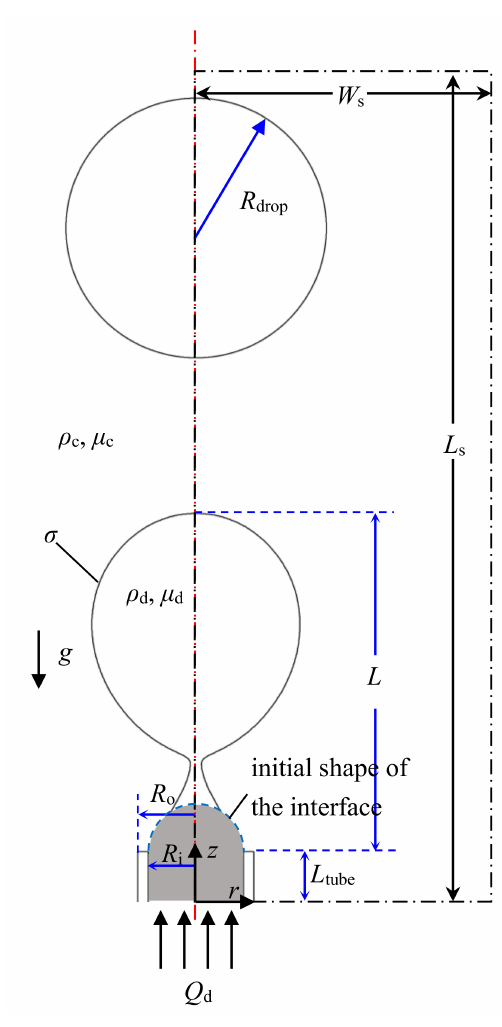
Figure 2. Schematic of the numerical simulation